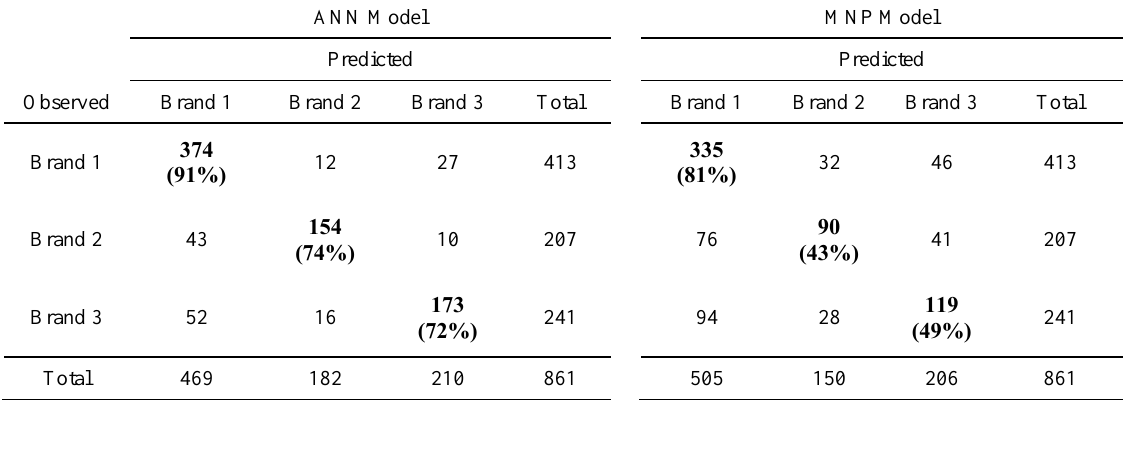
Table 5 Hit rates for NN and MNP models on the test sample